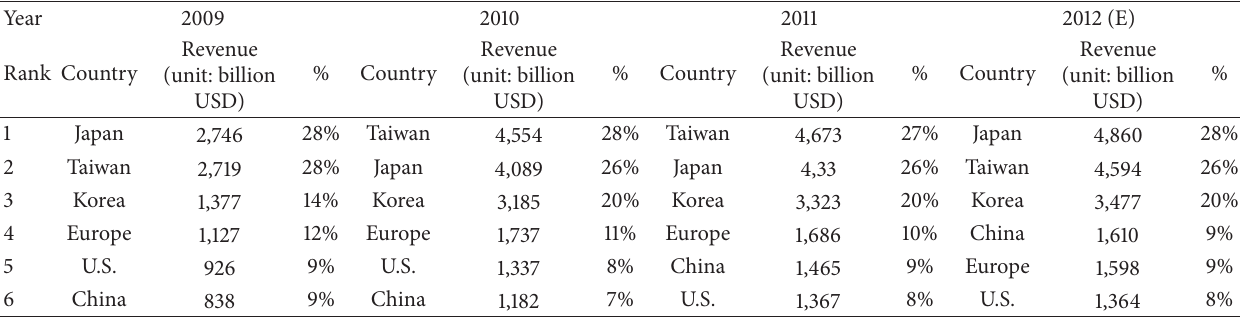
Table 3: Rank of revenue of global LED components industry (by country).